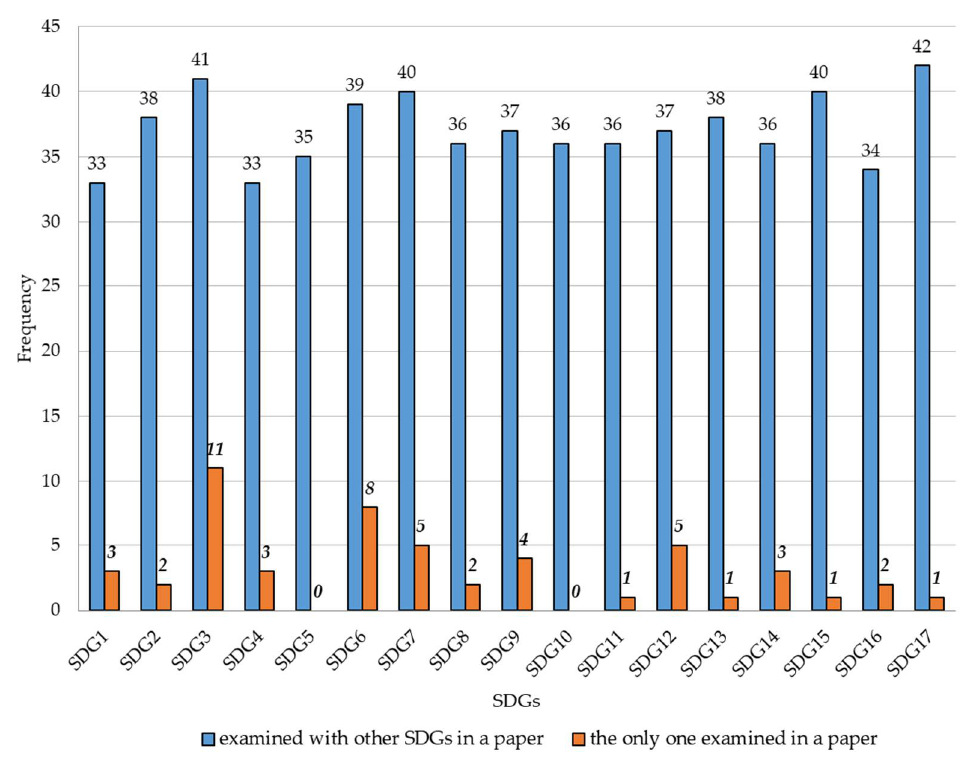
Figure 6. Frequencies of the SDGs examined with or without other SDGs in the SDG-related review paper.